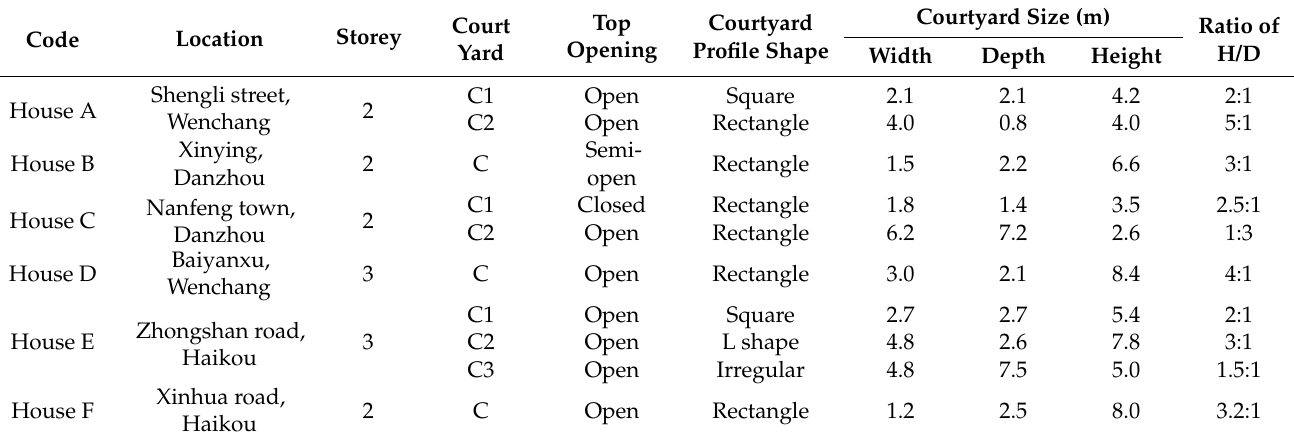
Table 3. General information about the internal courtyard of houses in filed